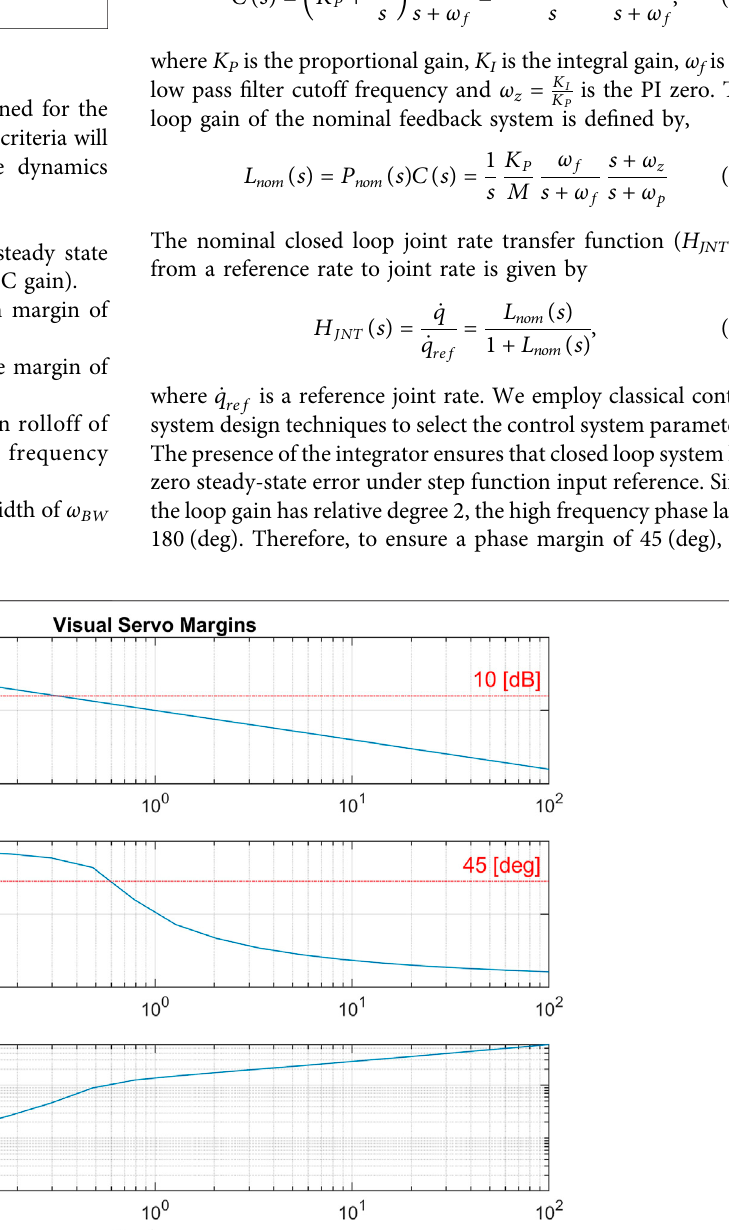
Frontiers in Robotics and AI |